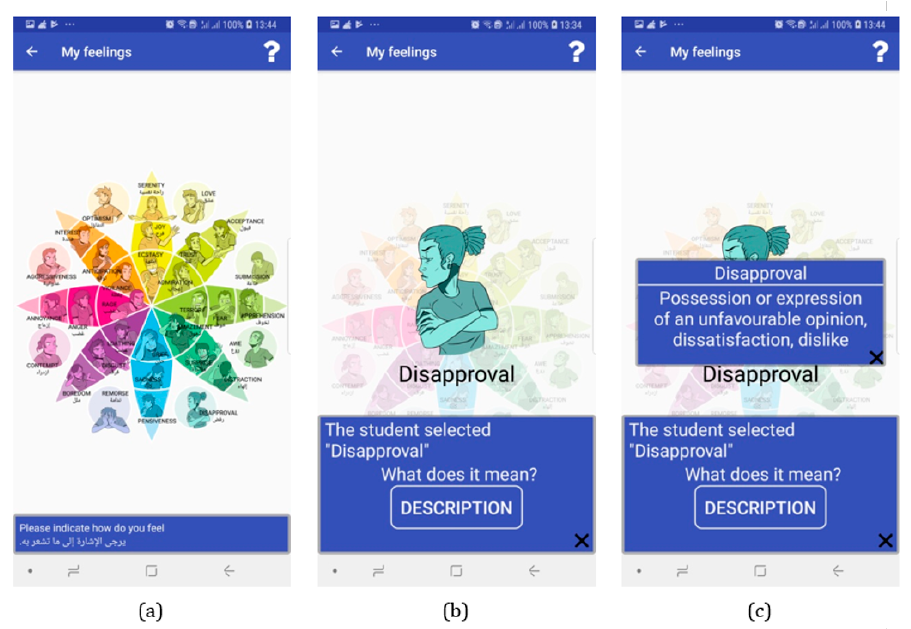
Figure 5. Robert Plutchik’s “wheel of emotions” as applied in project’s mobile application: ( a ) Se- lect the feeling, ( b ) Receive short clarification of what was selected, ( c ) Obtain explanation about the selected feeling